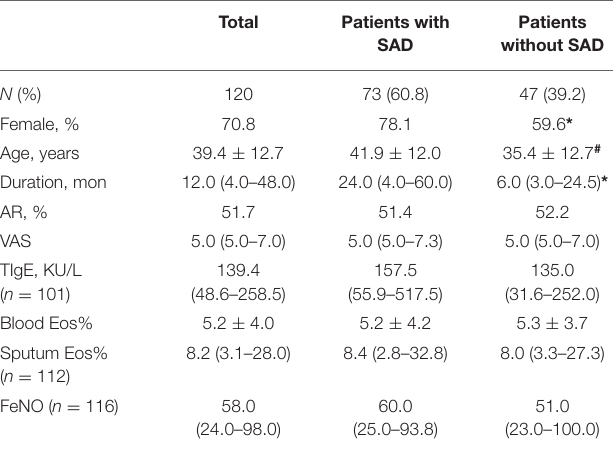
TABLE 1 | Demographics and baseline clinical characterization.